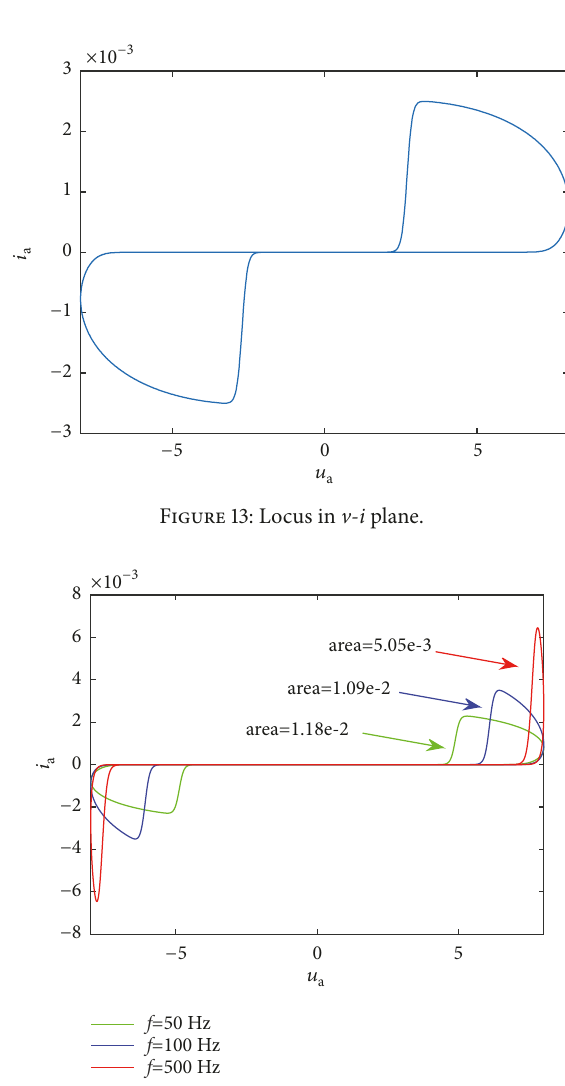
Figure 14: Curves of input voltage 𝑢 a and input current 𝑖 a